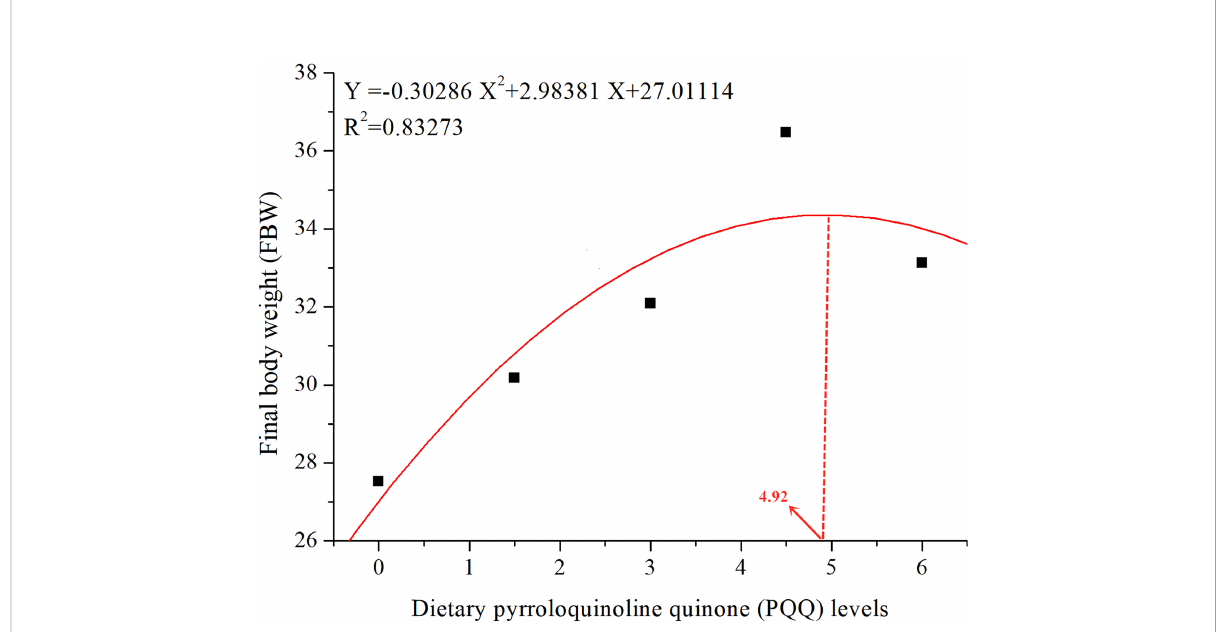
FIGURE 1 The relationship between the fi nal body weight (FBW) of juvenile yellow cat fi sh and different levels of PQQ supplemented diet after feeding for 8 weeks.